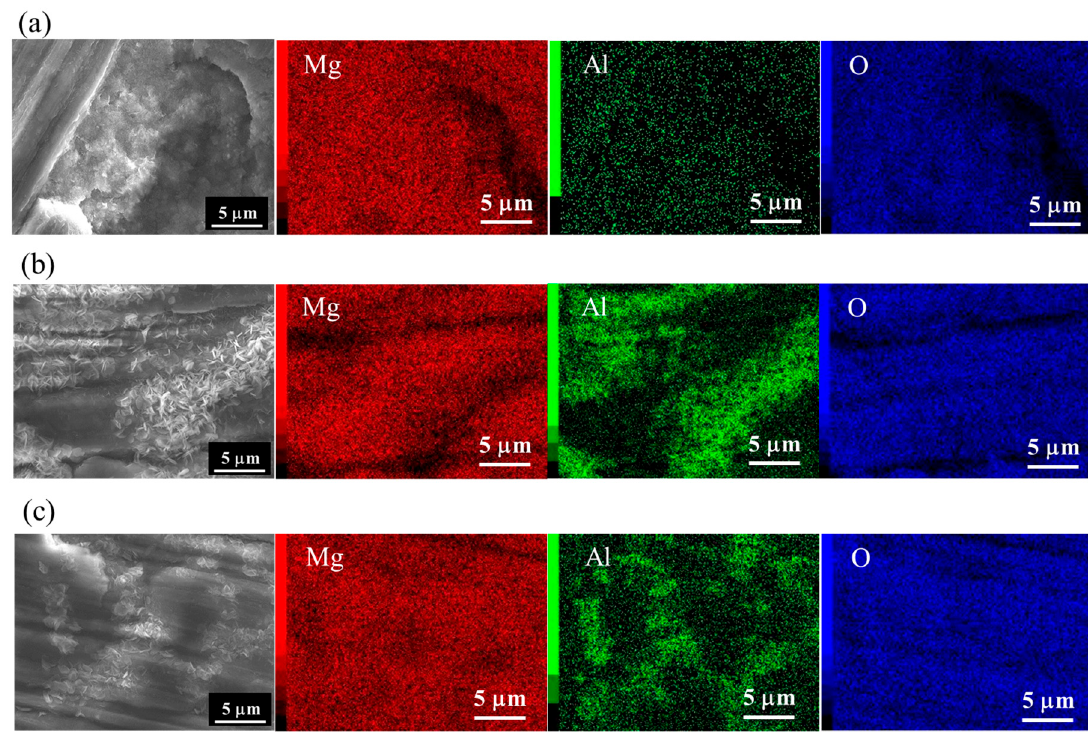
Figure 2. FESEM and elemental Mg, Al, and O mapping images of film prepared at 423 K for 5 h on ( a ) AZ31, ( b ) AZ61, and ( c ) AZ91D.